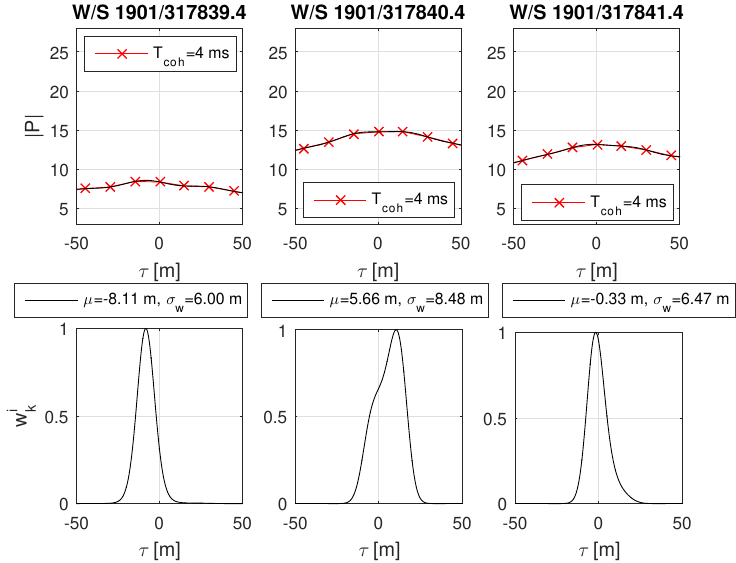
Figure 14. Real-world urban scenario of satellite GPS L1 C/A PRN 27. The plots show from left to right three epochs at different places in a urban environment, referring to the red dots from left to right in Figure 17. It is expected that the correlation values | P | vary significantly due to shadowing and multipath. The weighted mean is shifted for all positions and both the correlation and probability function of the second point (middle row) seem to be significantly affected by multipath. The red crosses in the upper plots show the correlation values at code offset τ . The black line in the upper plot shows the sinc interpolated correlation values, which are used to obtain the weights w i lower